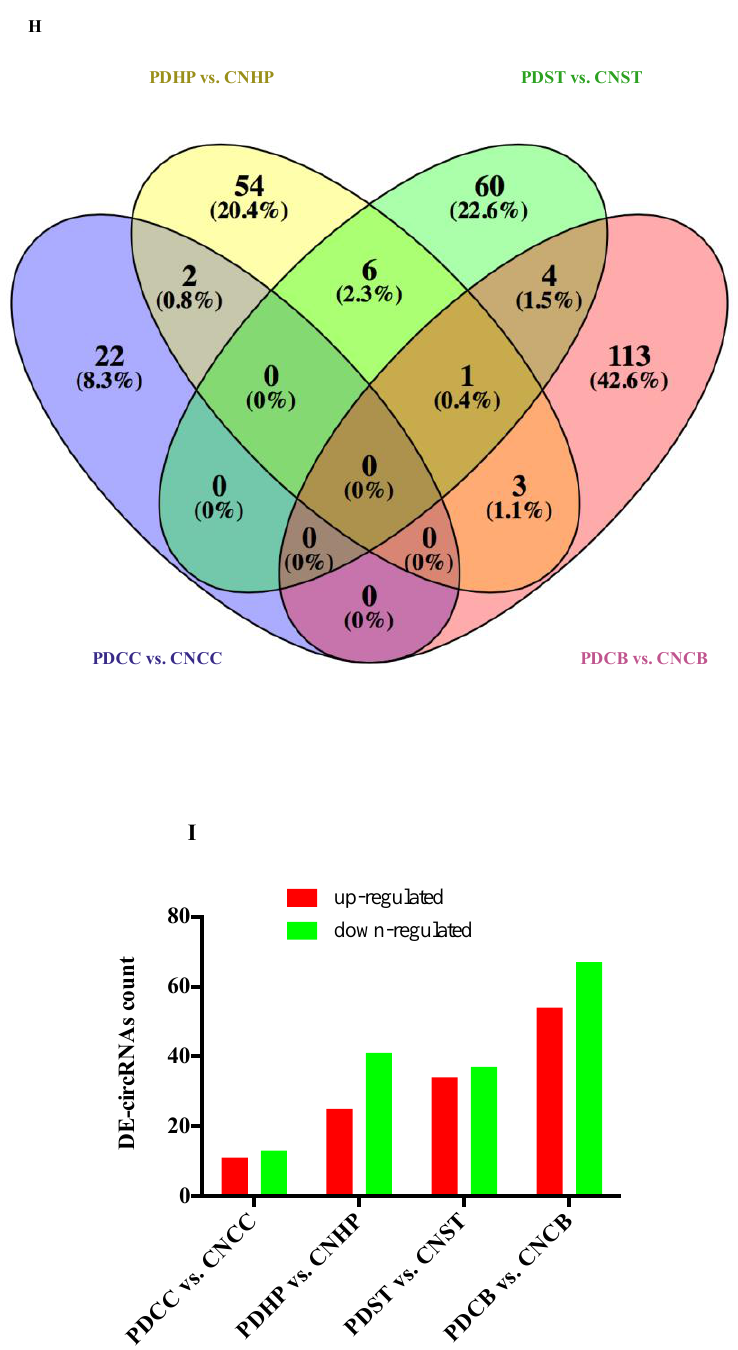
Figure 2. CircRNA expression profiling. ( A ) Heat map of circRNA expression in all samples in the di ff erent brain regions. ( B ) The heat map showing the expression of di ff erentially expressed circRNAs (DE-circRNAs) in the cerebral cortex (CC). ( C ) The heat map showing the expression of DE-circRNAs in the hippocampus (HP). ( D ) The heat map showed the expression of DE-circRNAs in the striatum (ST). ( E ) The heat map showed the expression of DE-circRNAs in the cerebellum (CB). ( F ) Column graph of chromosome distributed DE-circRNAs to di ff erent groups according to the source of their host genes in the CC, HP, ST, and CB regions. ( G ) Based on the genomic origin, the histogram shows the classification of DE-circRNAs in the CC, HP, ST, and CB regions. ( H ) Overlap of significant DE-circRNAs in di ff erent brain regions. ( I ) DE-circRNAs analysis of di ff erent brain regions. CN stands for control samples.